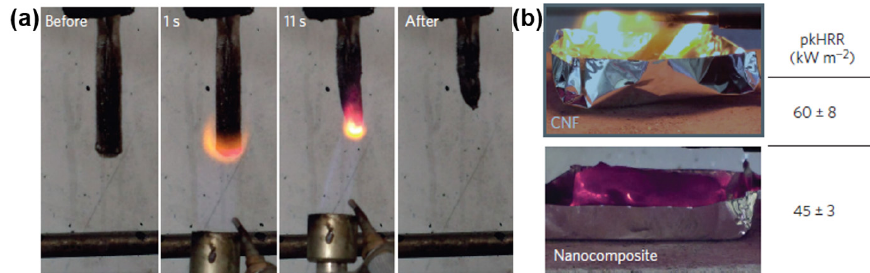
Figure 14. ( a ) Vertical burning test of a nanocomposite foam containing 77% CNF, 10% GO, 10% SEP and 3% BA (in wt %). The panel shows the foam before the test, after 11 s of application of a methane flame, and the foam after the test, showing high fire retardancy. ( b ) Photographs of CNF and CNF ‐ GO ‐ BA ‐ SEP nanocomposite foams during the cone calorimetry test together with the corresponding peak of heat release rates (pkHRR). The test reveals high combustion resistance for the nanocomposite foam at the limit of non ‐ ignitability, while CNF foams are entirely combusted. Reproduced with permission of Ref. [35] (Copyright Nature Publishing Group 2014).